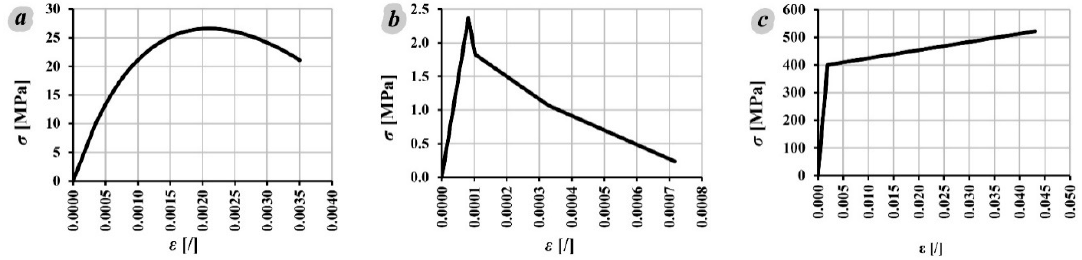
Figure 17. Stress–strain relationships: ( a ) for concrete at pressure, ( b ) for concrete at tension, and ( c ) for reinforcement.